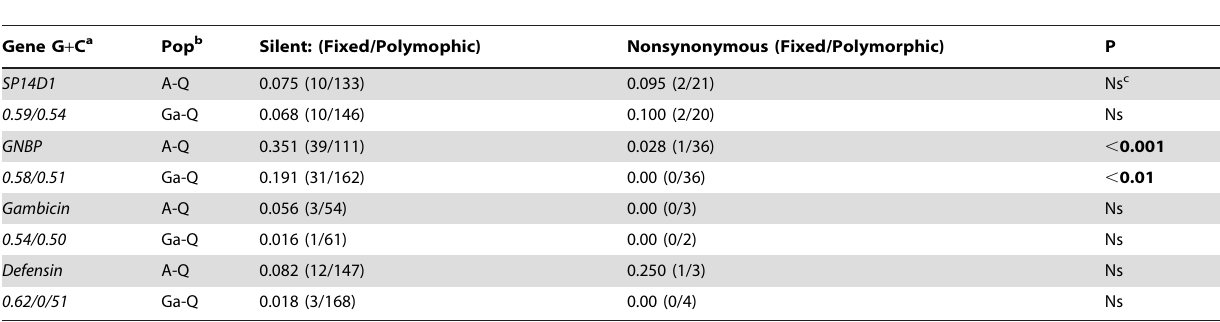
Table 5. McDonald Kreitman test (see text for